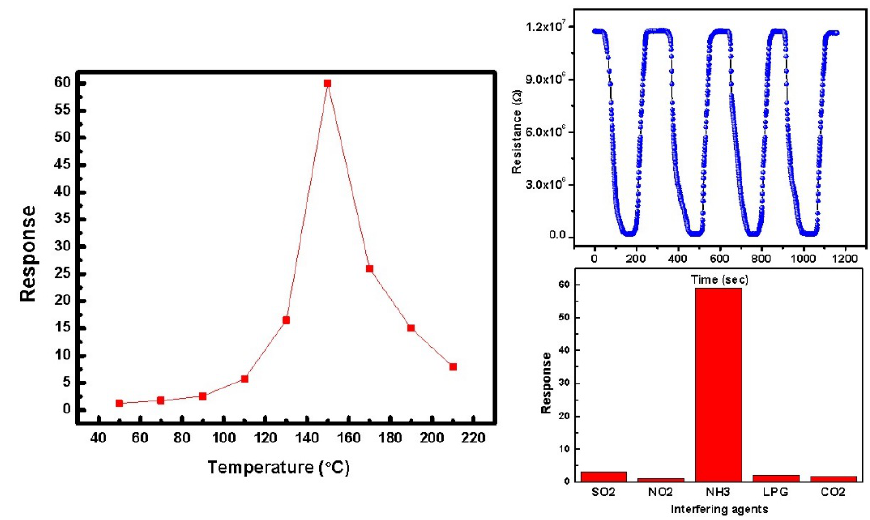
Figure 9. Response characteristics of the prepared sensor.